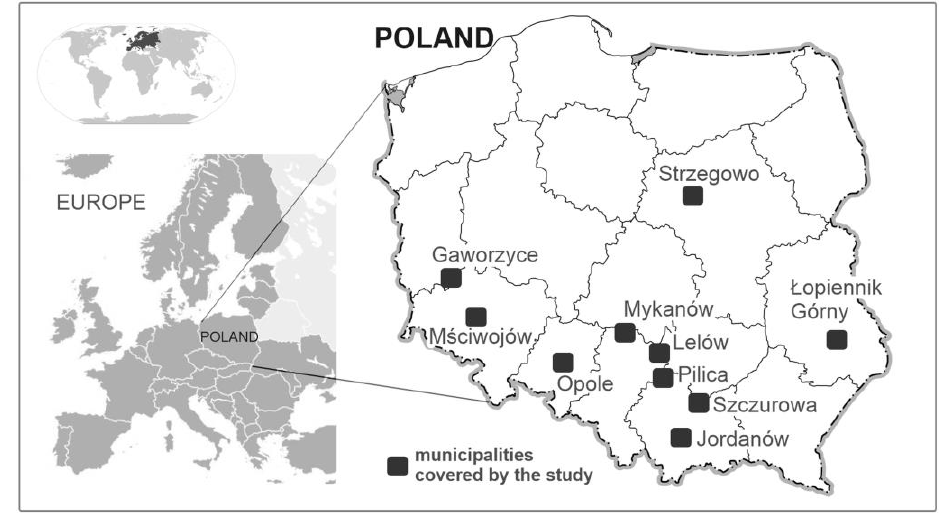
Figure 2. Location of the analyzed municipalities against the map of Europe and Poland.